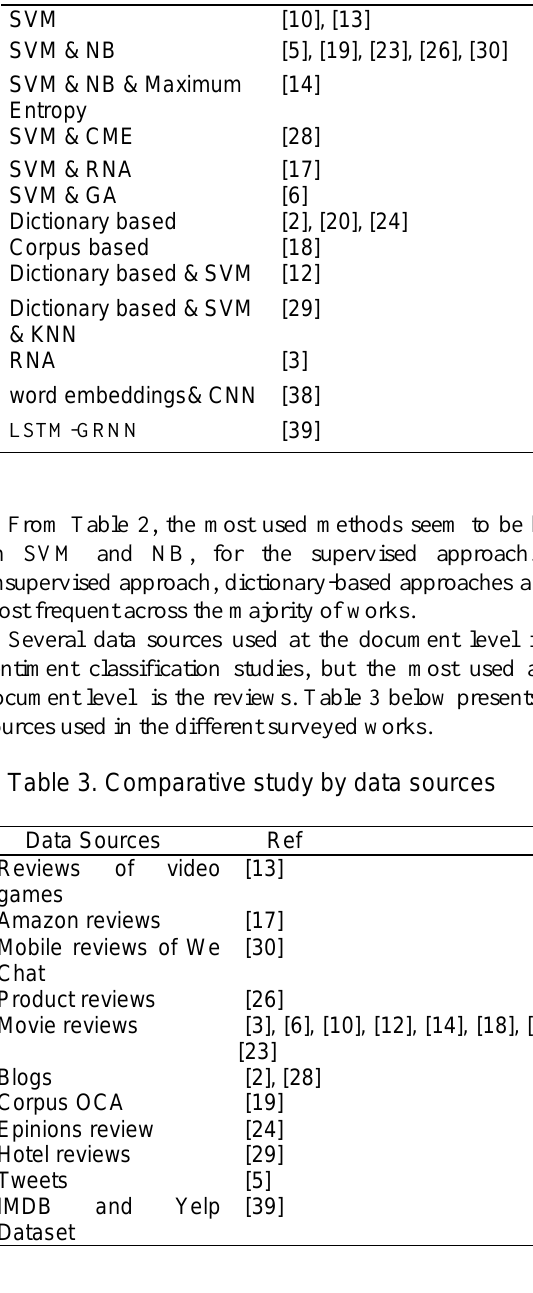
Table 4. Comparative study by feature construction Feature Construction